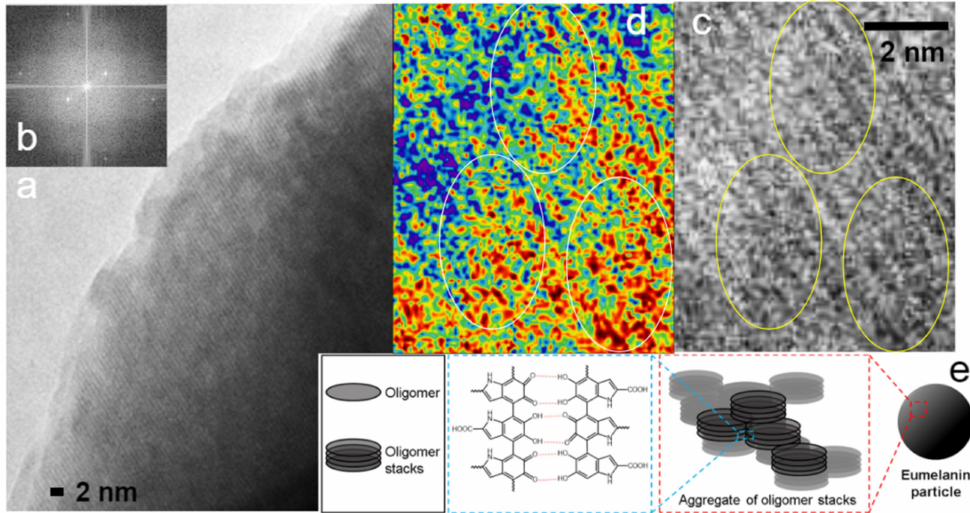
Figure 5. ( a ) Low-dose high-resolution TEM image of a melanin sample. The largest lattices that are visible have a spacing of 0.58 nm, which corresponds to the innermost pair of dots in the fast Fourier transformation image. ( b ) A Fourier transformation of a central region in Figure 5a. ( c ) A zoom-in of Figure 5a. ( d ) A color rendering of Figure 5c. Local crystalline packing of melanin is visible including knitted or spiral-like structures in the highlighted circles, which correspond to the fine structures inside the oligomer stack shown in Figure 5e. ( e ) The cartoon and molecular structures. Reproduced from [74] under the terms of the Creative Commons CC BY license [18]. No changes have been